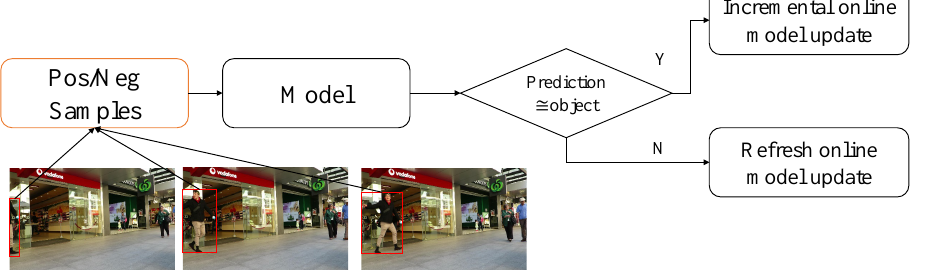
Figure 13. The model proposed in the paper of category distance and long occlusion handling [68] using the MOT15 Benchmark [8].